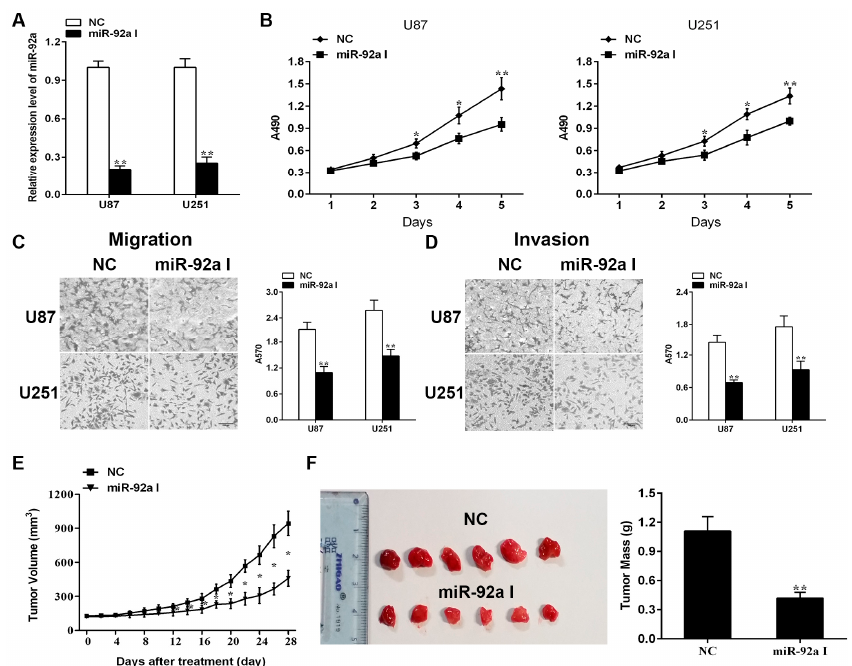
Figure 1. Effect of miR-92a-3p on the malignancy of glioma cells in vitro and in vivo. ( A ) Quantitative reverse transcription-polymerase chain reaction (qRT-PCR) analysis of miR-92a-3p expression in glioma cells 48h-post transfection with miR-92a-3p I; ( B ) The rates of cell viability were quantified using a methyl-thiazolyl-tetrazolium (MTT) assay; Cell migration ( C ) and invasion ( D ) was detected by Transwell assay; ( E ) Tumor volumes were measured every two days during treatment; ( F ) Mice were sacrificed 28 days following miR-92a-3p I injection and the tumors were weighted. All Transwell images were photographed at 100× original magnification. Each bar represents the mean of three independent experiments. * indicates p < 0.05, ** indicates p < 0.01. Scale bar represents 200 µm.